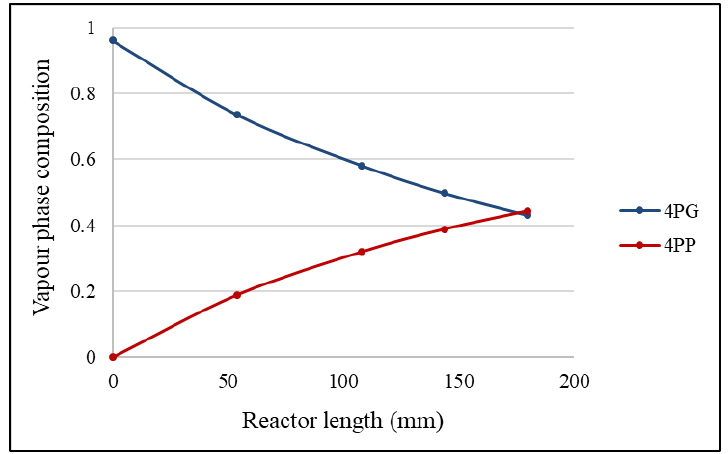
Figure 4. Vapor phase mass composition along the microreactor for 4-propylguaiacol and 4- propylphenol. Reaction conditions: Temperature, 400 °C; pressure, 300 psig; gas phase, hydrogen; liquid phase, 4-propylguaiacol; liquid flow rate, 0.03 mL · min − 1 ; gas flow rate, 0.09 mL · min − 1 .